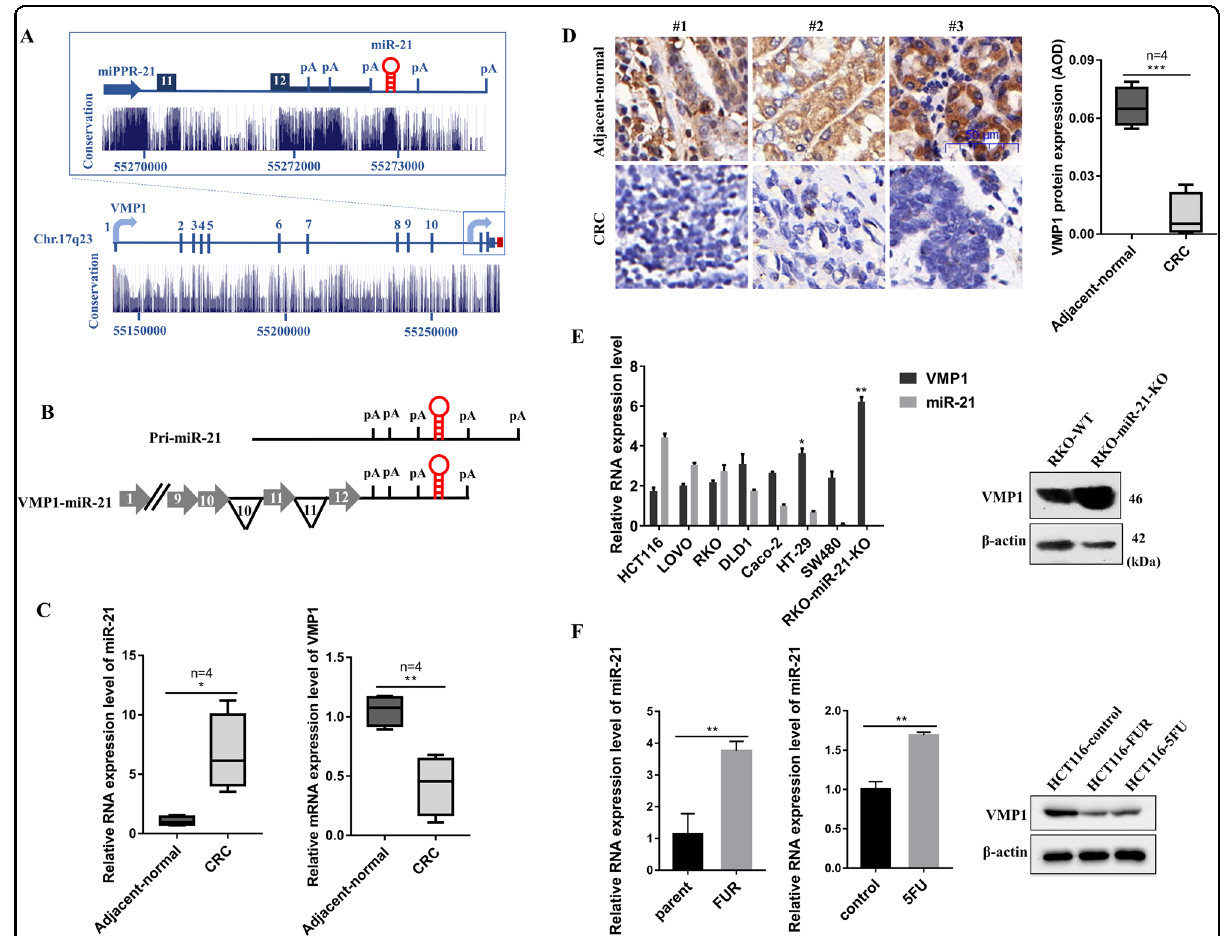
Fig. 1 The expression of miR-21 is negatively correlated with VMP1 in colorectal cancer. a Structure of the VMP1 and miR-21 loci at chromosome 17q23. VMP1 exon numbers are noted, inset highlights the pri-miR-21 gene region. The blue-black arrow is situated at the miR-21 promoter, miPPR-21. The line of intermediate thickness indicates the 3-UTR of VMP1. The red hairpin indicates the location of the pre-miR-21 hairpin. Polyadenylation signals are indicated as pA. Evolutionary conservation (UCSC Genome Browser 28 species conservation track, NCBI36/hg18 assembly) is plotted below. b Schematic of the transcripts pri-miR-21 and VMP1-miR-21. Horizontal gray arrows represent exons and black lines represent introns (numbered in black) and non-coding sequences. Break symbols (double slash mark) are placed between exons 1 and 9 of VMP1. c qPCR analysis for miR-21 and VMP1 expression in colorectal cancer tissues and adjacent non-cancer tissues. d IHC analysis for the protein expression level of VMP1 in colorectal cancer tissues and adjacent non-cancer tissues. e The mRNA expression level of miR-21 and VMP1 was measured by qPCR in various colorectal cancer cells. The protein expression of VMP1 was measured by Western blot in parental RKO and RKO-miR-21-KO cells. f The mRNA expression of miR-21 was measured by qPCR, the protein expression of VMP1 was measured by Western blot in HCT116 cells treated with 10 µM 5-FU for 24 h and HCT116-5FUR cells, compared with the control group. (Scale bars, 50 µm) Data are presented as mean ± SD. *** P < 0.001, ** P < 0.01, * P <